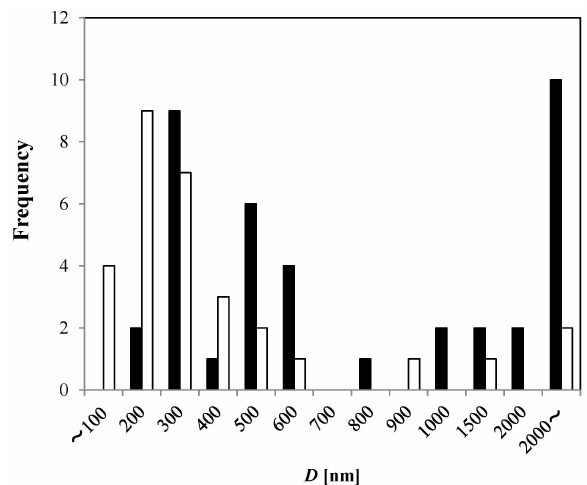
Figure 2. Apparent bubble diameter ( D ) observed from TEM-freeze-fracture replica method in 0 mM NaCl solution after 1 h MNB generation (solid bar, n = 39), and in pure water without MNB generation (open bar, n =